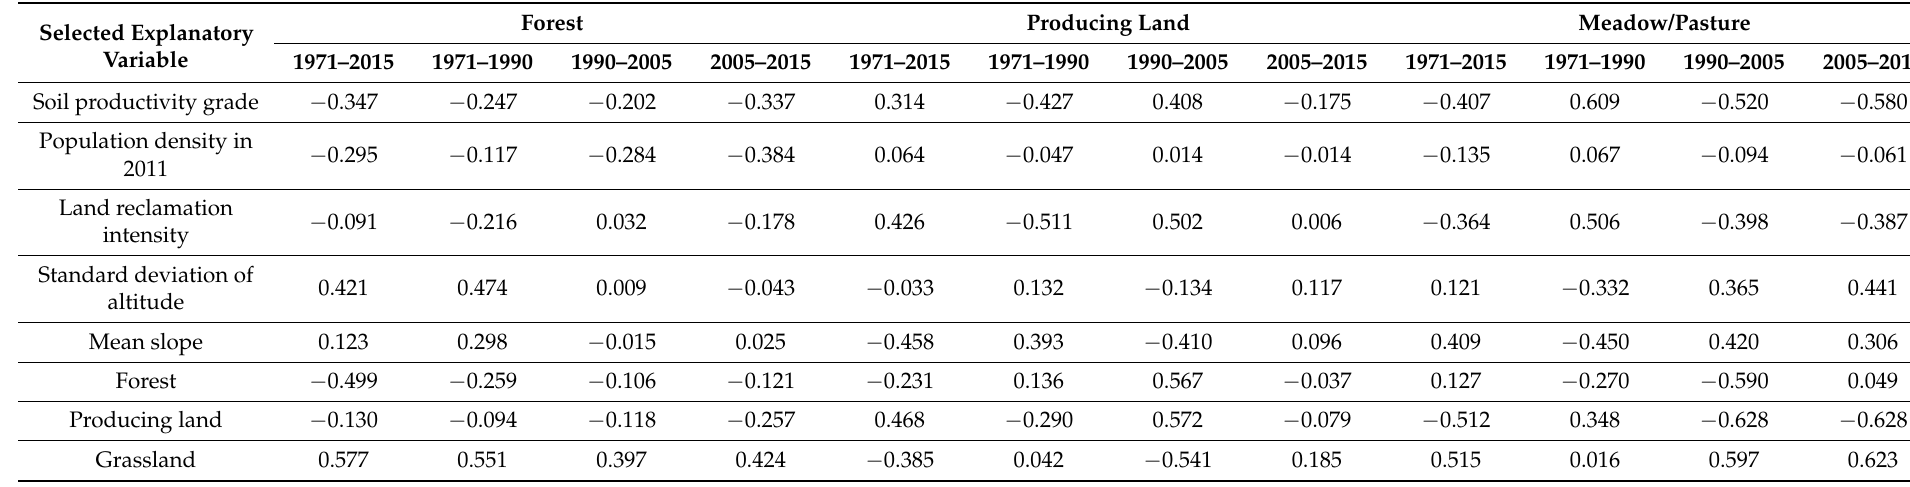
Table 3. Pearson’s correlation coefficient between a selected explanatory variable and the slope of the linear trend in the development of a specific land-use proportion over a certain period ( N =